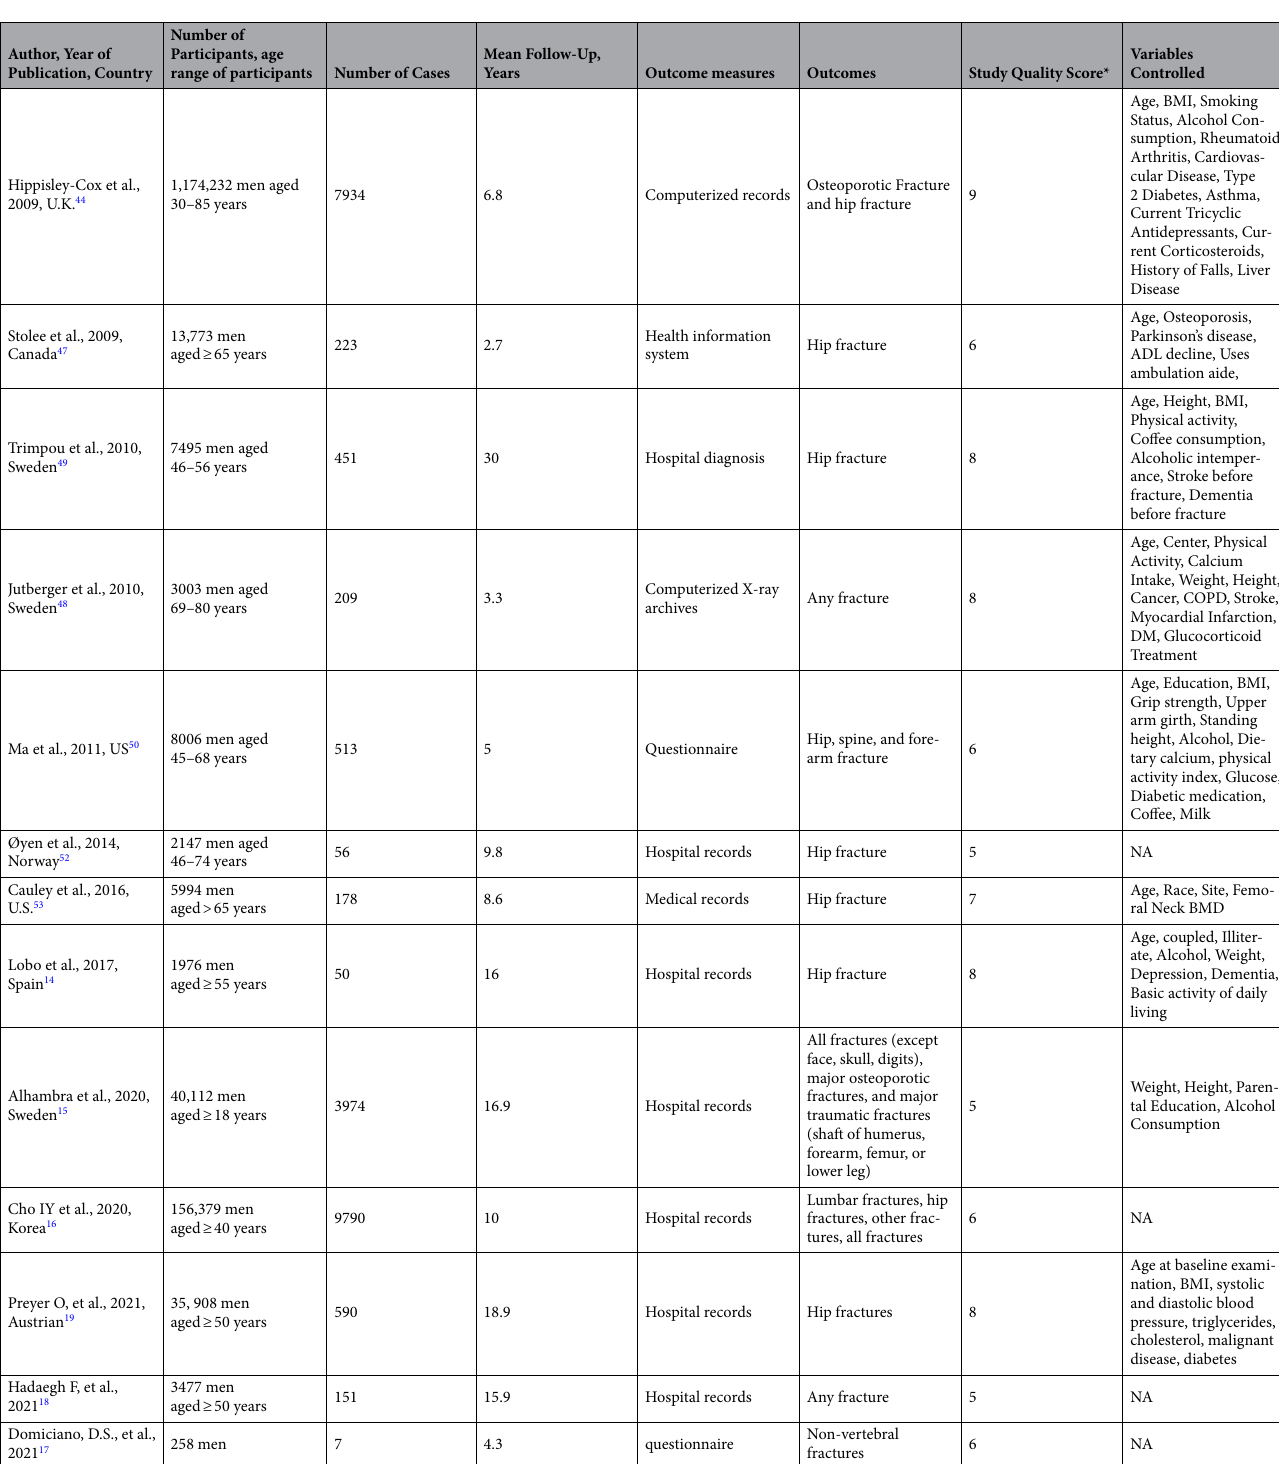
Table 1. Characteristics of twenty-three studies examining the association between smoking status and fracture risk. Abbreviations BMI Body mass index, BMD Bone mineral density, COPD Chronic obstructive pulmonary disease. *The Newcastle–Ottawa Scale was used for quality